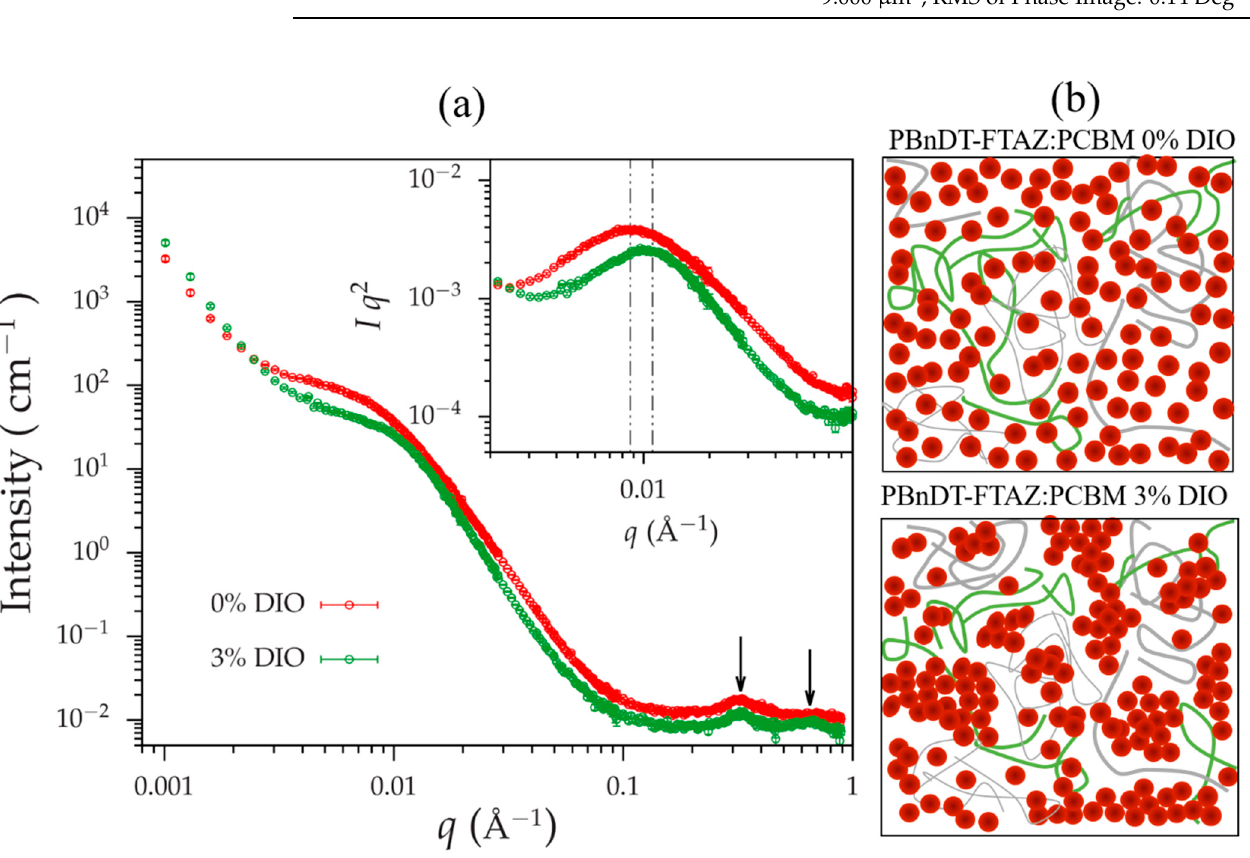
Figure 5. ( a ) 1D SANS profiles of films of PBnDT-FTAZ: PCBM with (3%) and without DIO and ( b ) Schematic of hierarchical structures in those blends.